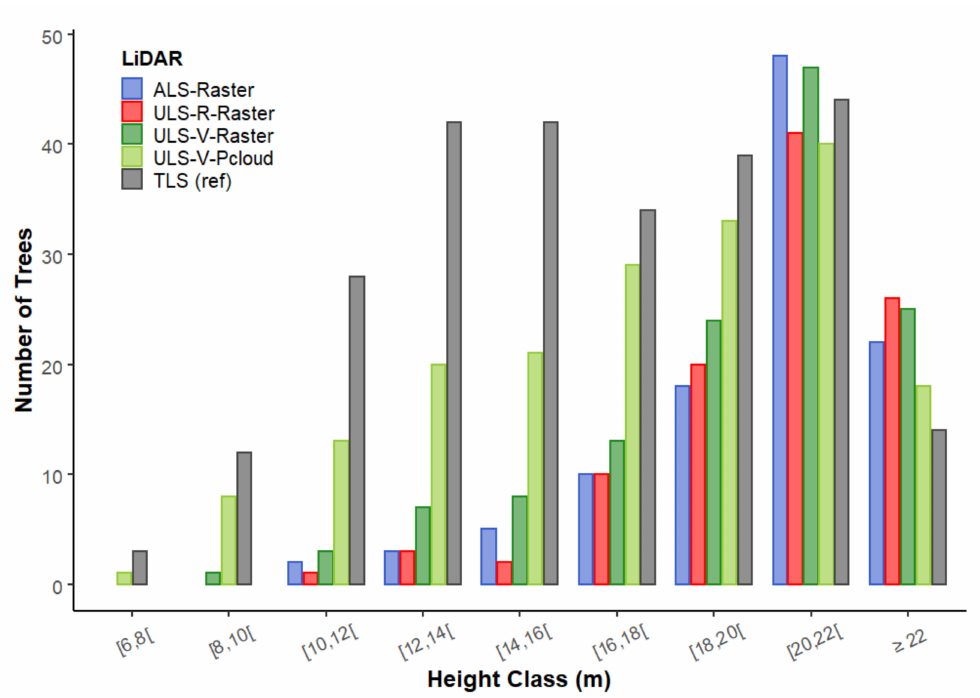
Figure 12. The distribution of trees, by height class, detected from ALS-Raster (leaf-on), ULS-R-Raster (leaf-on), ULS-V-Raster (leaf-off), and ULS-V-Pcloud (leaf-off) that were matched with a TLS reference tree (Ntrees paired